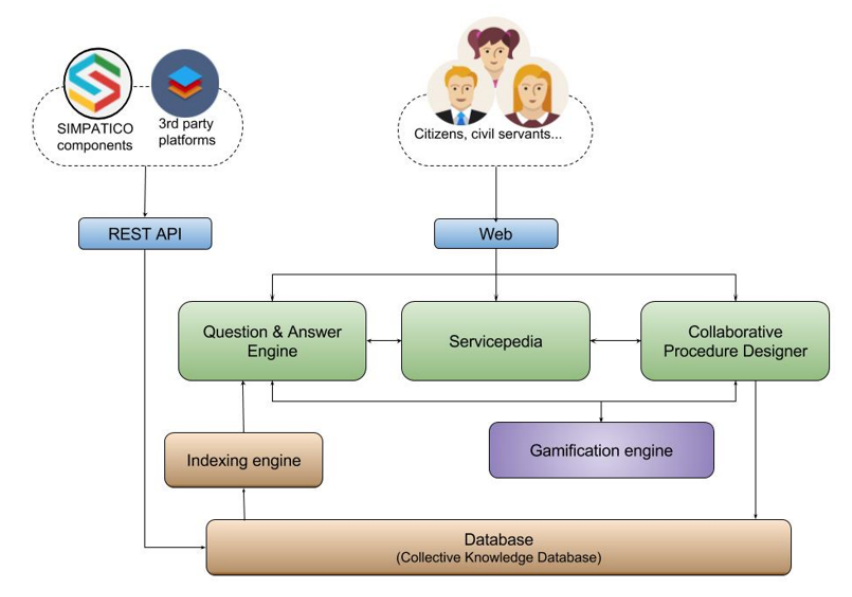
Figure 4. Citizenpedia